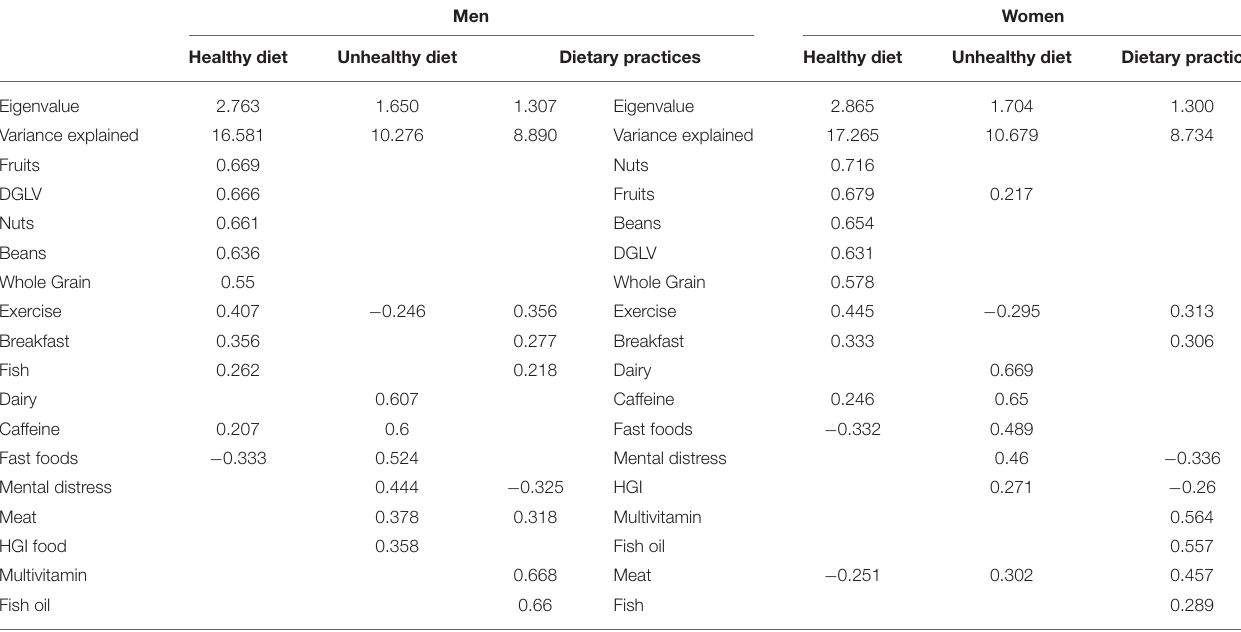
TABLE 3 | PCA analysis on data stratified by gender with varimax rotation.